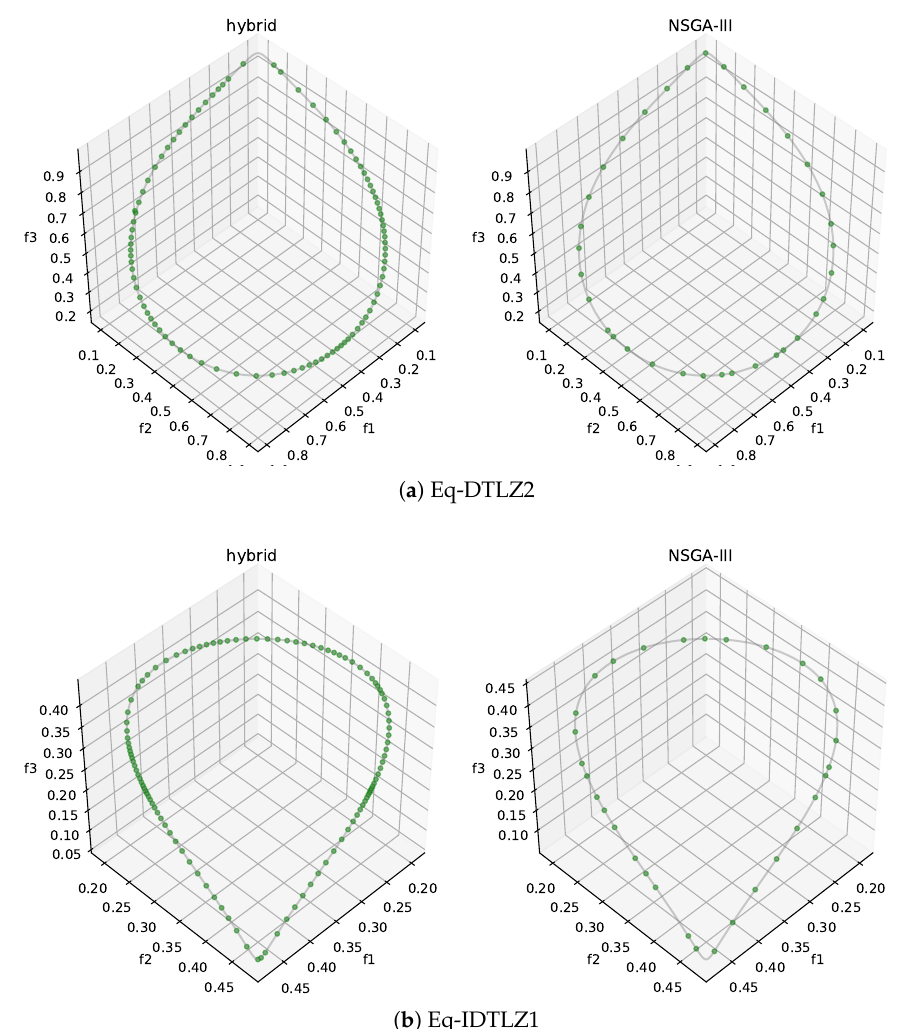
Figure 6. On the Eq-DTLZ2 ( a ) and the Eq-IDTLZ1 ( b ) problem, we compare the hybridization of HVN and NSGA-III to NSGA-III with roughly the same budget: for the former, the hybrid algorithm first executes NSGA-III with µ = 200 for 1000 iterations and then runs the HVN method for 10 iterations. In HVN, the total function evaluations and AD takes ca. 270 s CPU time on an Intel(R) Core(TM) i5-8257U CPU, which corresponds to ca. 4.8 10 5 FEs. Hence, for the latter, we set × 3400 (=4.8 10 5 / 200 + 1000) iterations in total for µ = 200. We use the same hyperparameter setting × for the standalone NSGA-III and the one used in the hybridization. The decision space is [ 0,1 ] 11 , and the reference point is ( 1,1,1 ) (cid:62) for